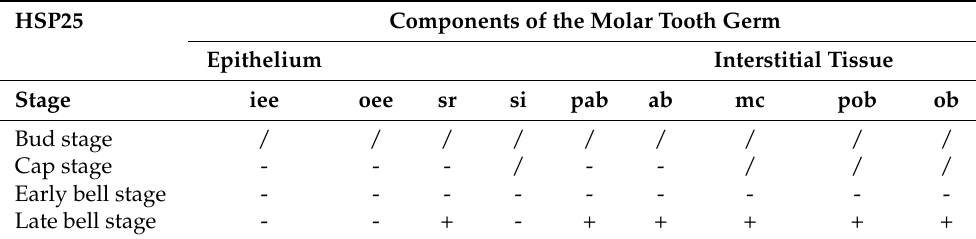
Table 1. Expression of heat shock protein 25 (HSP25) in the tooth germs of mandibular first molar in mice. HSP25 Components of the Molar Tooth Germ Epithelium